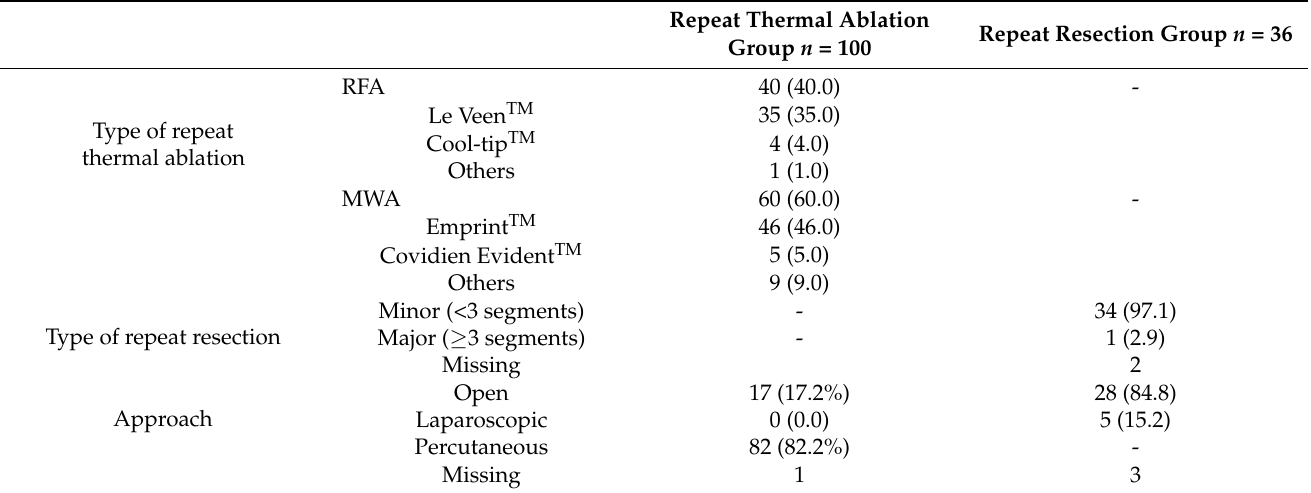
Table 2. Treatment characteristics of repeat local treatment.